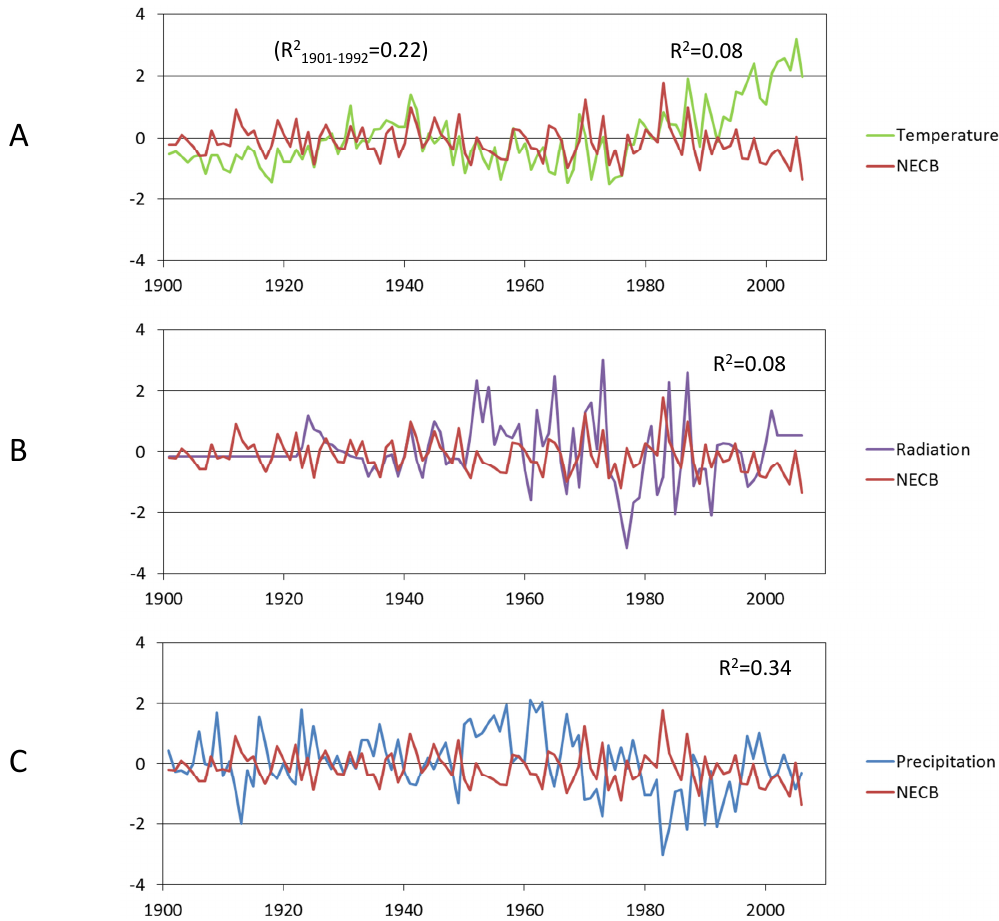
Fig. B2. Time series of standardised anomalies for simulated NECB for the African continent and (A) temperature, (B) radiation (% sunshine) and (C) precipitation and associated correlation coefficients. For temperature, the correlation coefficient for a shorter period (1901–1992) is shown in